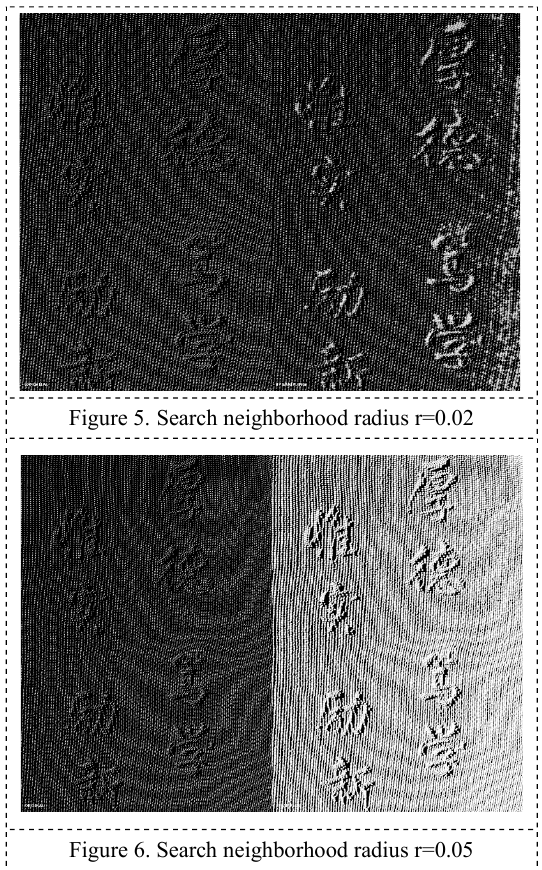
Figure 6. Search neighborhood radius